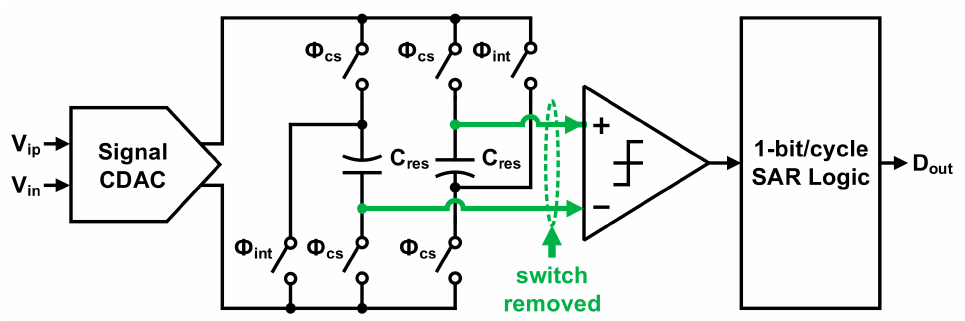
Figure 5. First-order noise-shaping SAR ADC architecture for fine conversion.